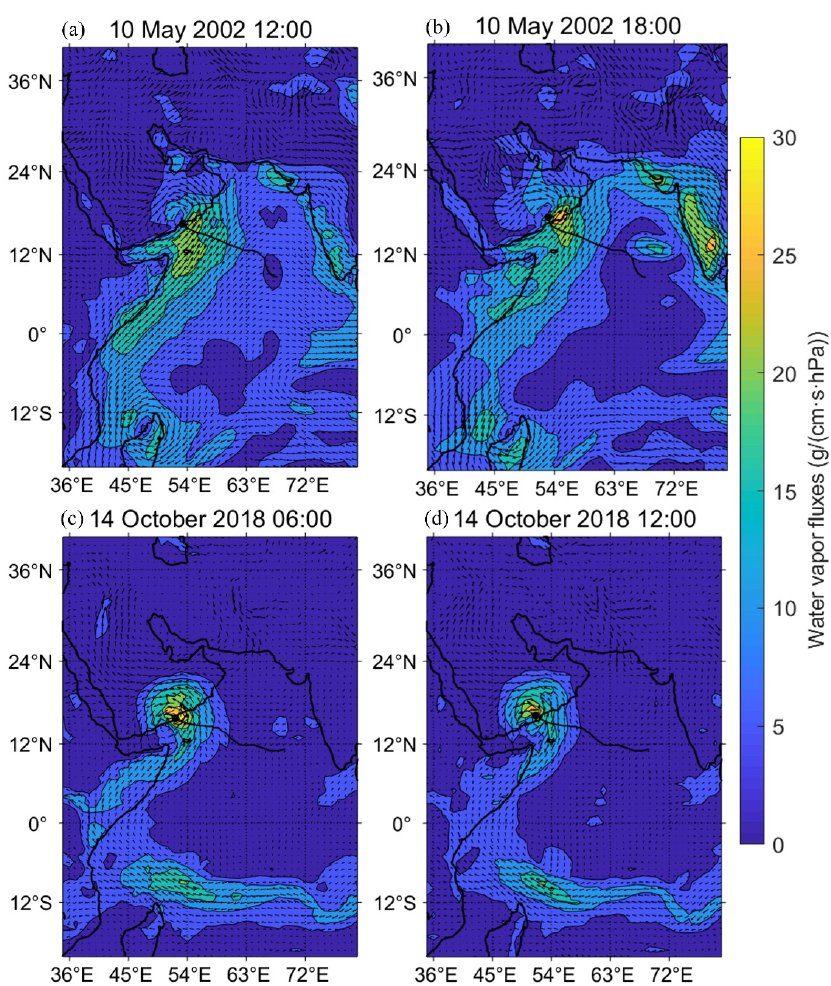
Figure 5. Water vapor fluxes distribution of ARB 01 on ( a ) 10 May 2002 12:00, and ( b ) 10 May 2002 18:00 at level = 850 hPa and Luban on ( c ) 14 October 2018 06:00, and ( d ) 14 October 2018 12:00 at level = 850 hPa. Black dots indicate the TC center.